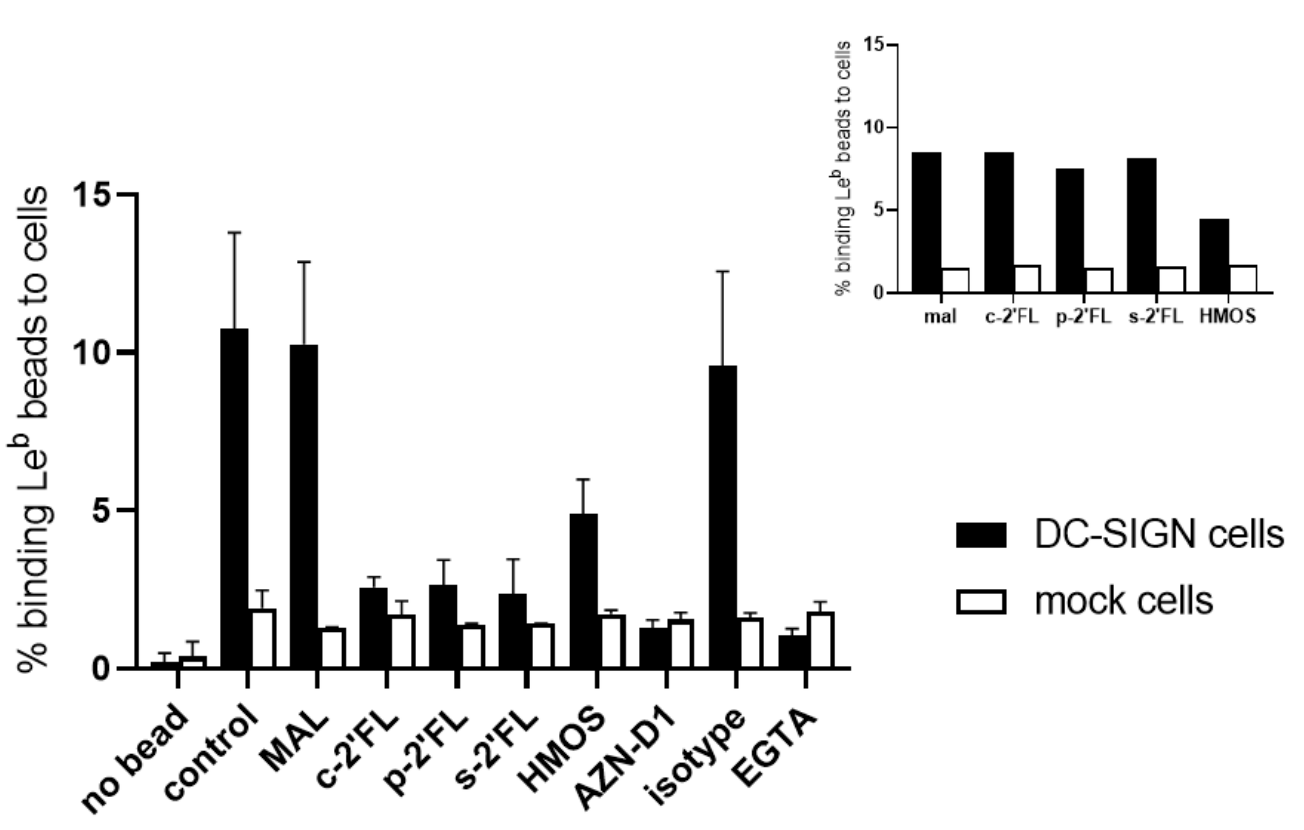
Figure 3. Cell-ligand competition assay with the DC-SIGN expressing cells and mock cells and c2 ꞌ - FL, p2 ꞌ -FL, s2 ꞌ -FL, HMOS, maltotriose (MAL, negative control of the 2 ꞌ -FLs and HMOS), isotype antibody (negative control), AZN-D1 (DC-SIGN binding antibody, positive control), and EGTA (as the inhibition control). At a 5 mg/mL concentration of c2 ꞌ -FL, p2 ꞌ -FL, and s2 ꞌ -FL, the HMOS inhibits the binding of the Le b coated fluorescent beads to the DC-SIGN expressing cells. The insert shows the inhibition effect in the 1 mg/mL concentration of c2 ꞌ -FL, p2 ꞌ -FL, s2 ꞌ -FL, HMOS. Results are presented as the mean % of the cells binding the Le b - coated fluorescent beads +/- SD, the data from two separate experiments were performed in duplicate (n = 4 technical replicates). For the insert, n = 2 technical replicate. c-2 ꞌ -FL = biotechnologically produced commercially available 2 ꞌ -FL, p2 ꞌ -FL = purified c-2 ꞌ -FL, and s2 ꞌ -FL = chemically synthesized 2 ꞌ -FL.